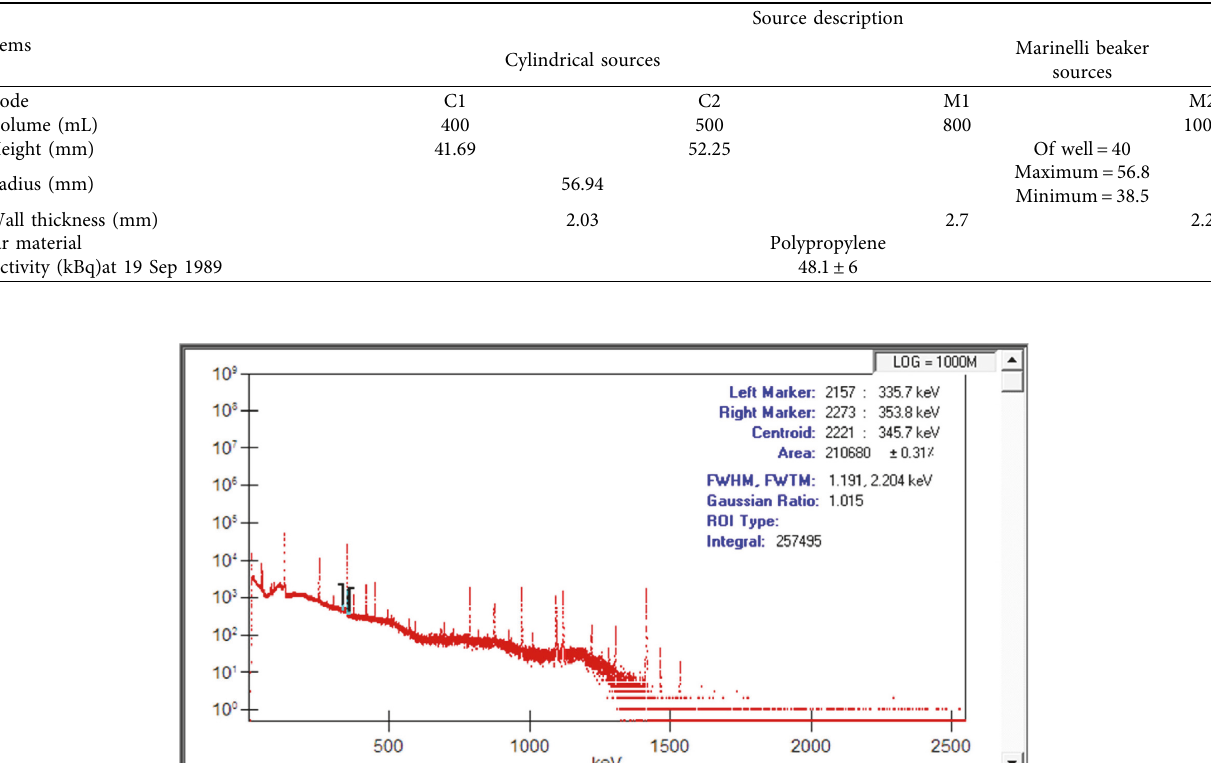
Figure 2: The radioactive volumetric sources used in the Table 2: The characteristics of different volumetric sources used in practical measurements.